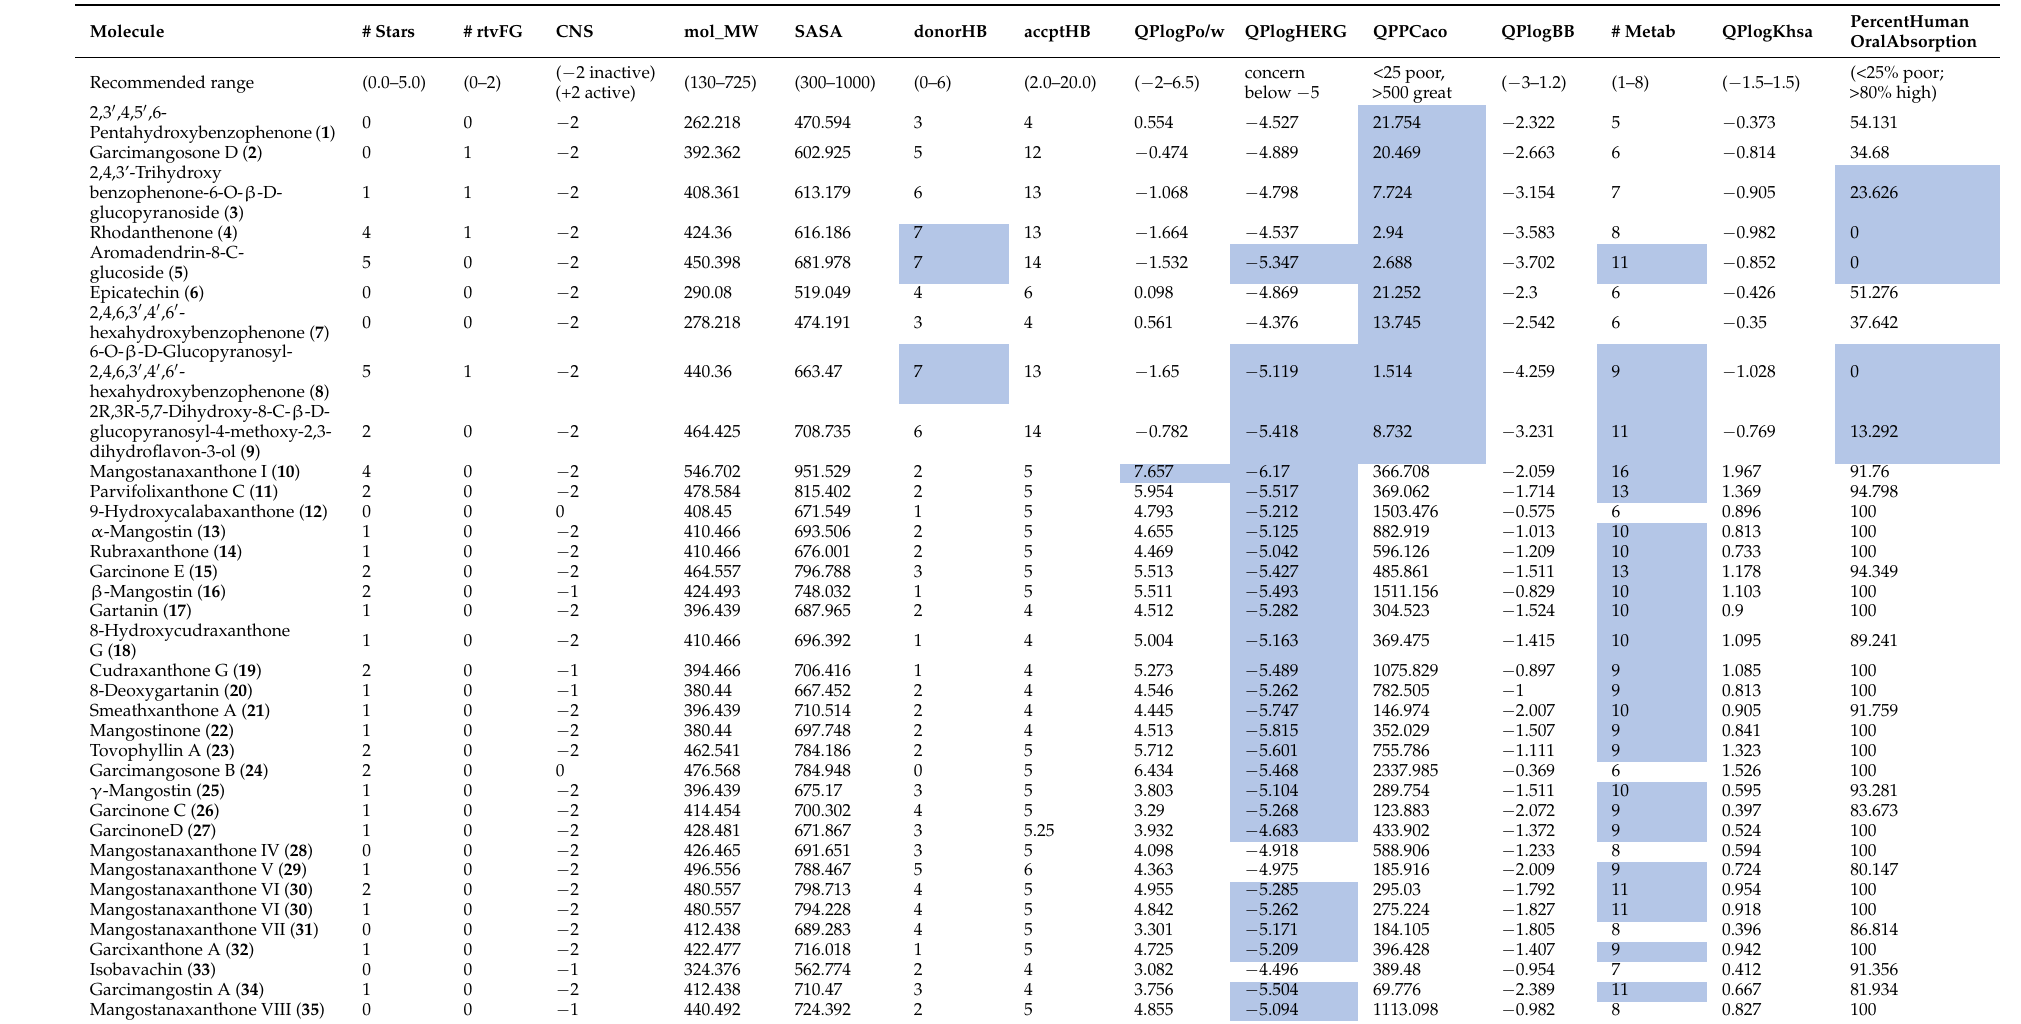
Table 1. In silico predicted ADME properties of the tested